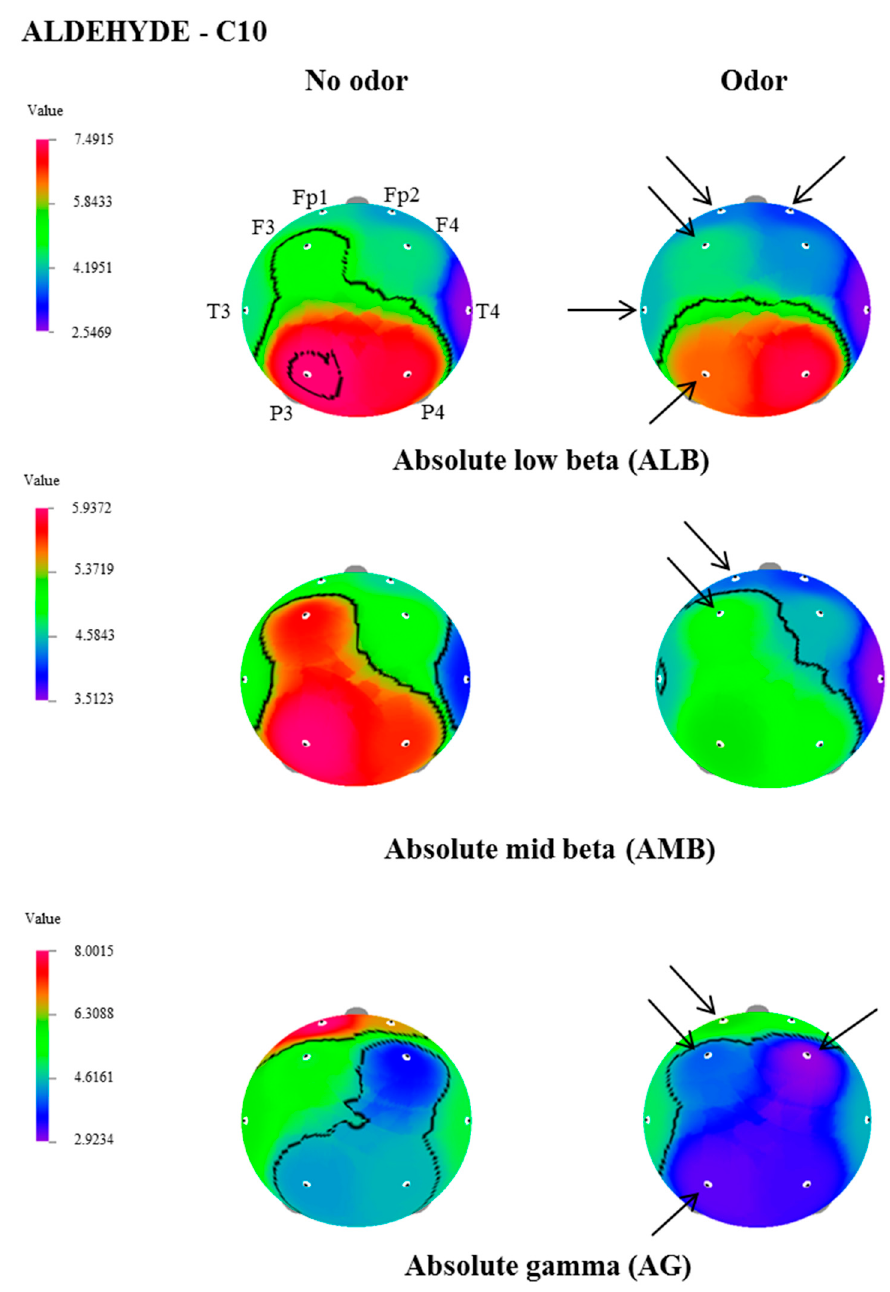
Figure 4. The t-Mapping of EEG power spectrum changes during the right nostril inhalation of C10 aldehyde. Fp1, left prefrontal; Fp2, right prefrontal; F3, left frontal; F4, right frontal; T3, left temporal; T4, right temporal; P3, left parietal; P4, right parietal. Arrows show significant changes in the regions during the inhalation of C10.